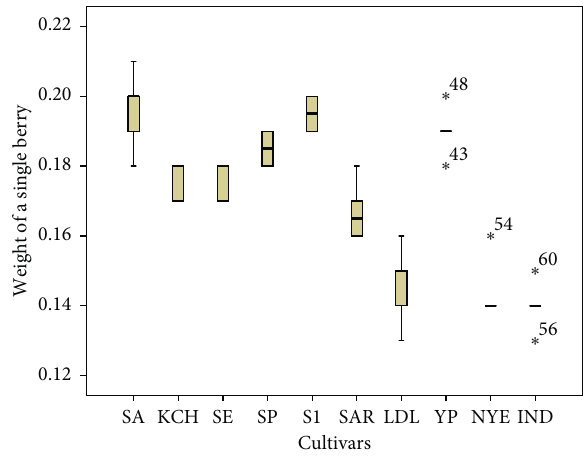
Figure 14: Conversion rate (fresh to dried white pepper) (%).